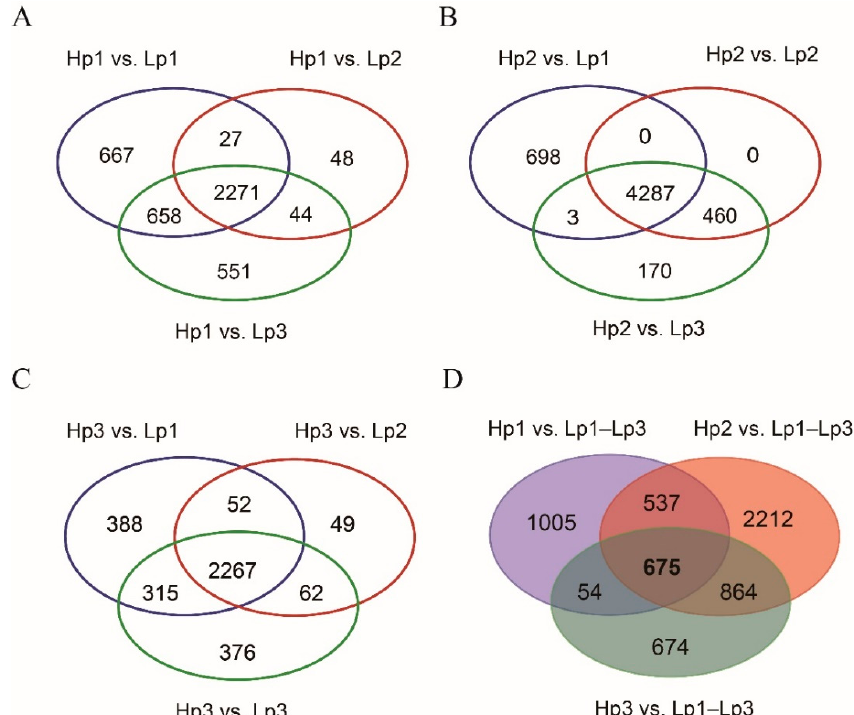
Figure 2. The common upregulated genes of the high-altitude B. pyrosoma compared to the low-altitude B. pyrosoma . ( A ) The upregulated genes of high-altitude B. pyrosoma at the first sampling site compared to the three sites of low-altitude B. pyrosoma . ( B ) The upregulated genes of high-altitude B. pyrosoma at the second sampling site compared to the three sites of low-altitude B. pyrosoma . ( C ) The upregulated genes of high-altitude B. pyrosoma at the third sampling site compared to the three sites of low-altitude B. pyrosoma . ( D ) The common upregulated genes of high-altitude B. pyrosoma among the three sampling sites. Hp represents high-altitude B. pyrosoma samples, Lp represents low-altitude B. pyrosoma samples, and the Arabic numerals indicate each sampling site.